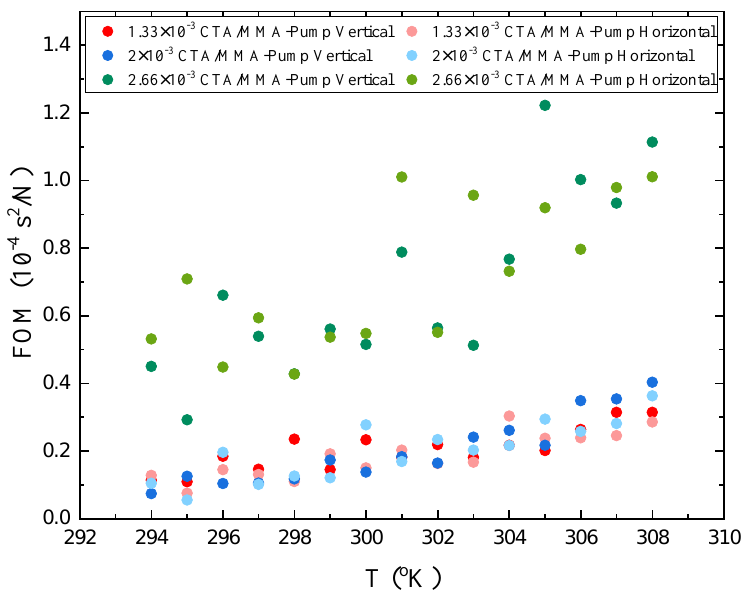
Figure 19. Figure of merit as a function of temperature for fibers with different CTA concentrations. The result is derived using κ ( 1 ) ( T ) and E ( T ) as shown in Equation